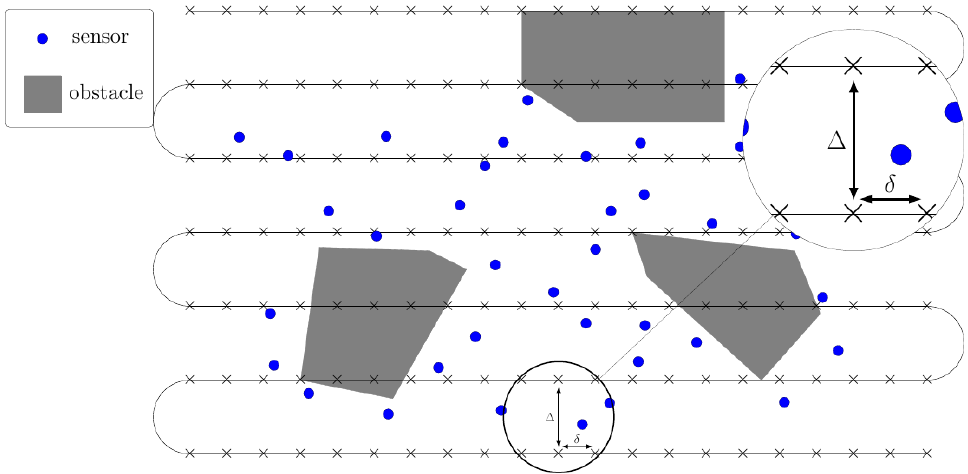
Figure 4. Photogrammetry trajectories for sensor location estimation.